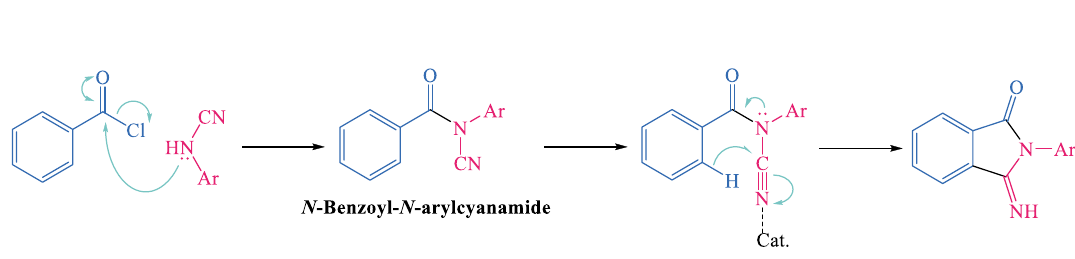
Figure 9. 13 CNMR spectrum of 2-(4-chlorophenyl)-3-iminoisoindolin-1-one.